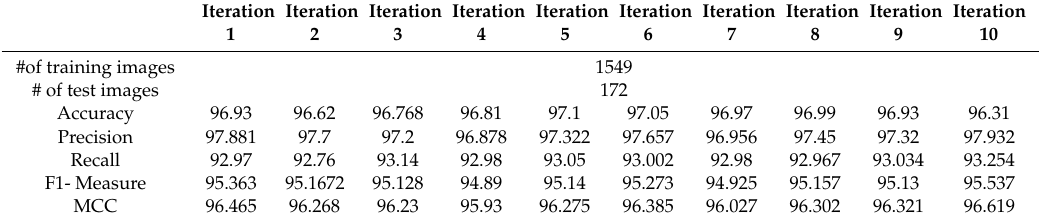
Table 3. The detailed results of 10-fold cross-validation on CASIA V1.0 using the proposed model. Iterat